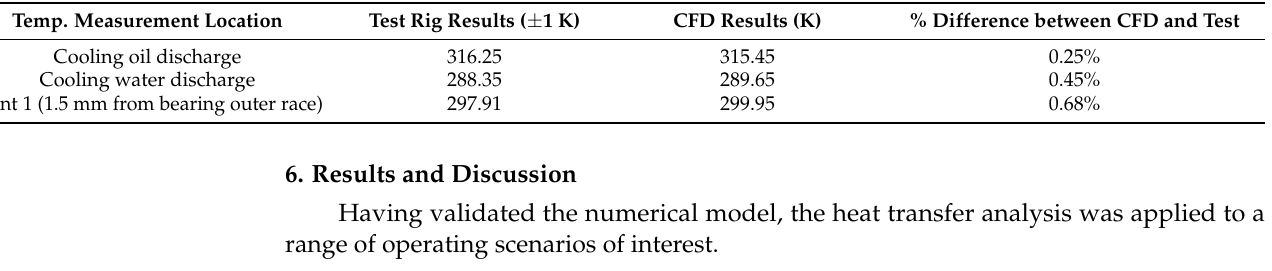
Table 6. Comparison between the CFD and test rig results at the validation